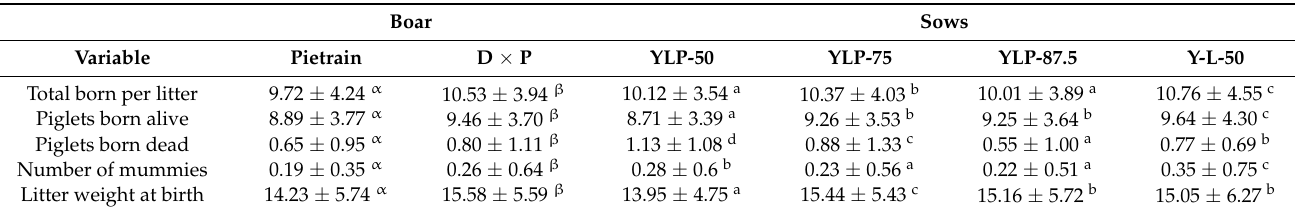
Table 2. Fertility variables (mean ± s.d.) of litter size and piglet mortality of according to source of boar semen and in different lines of sows.